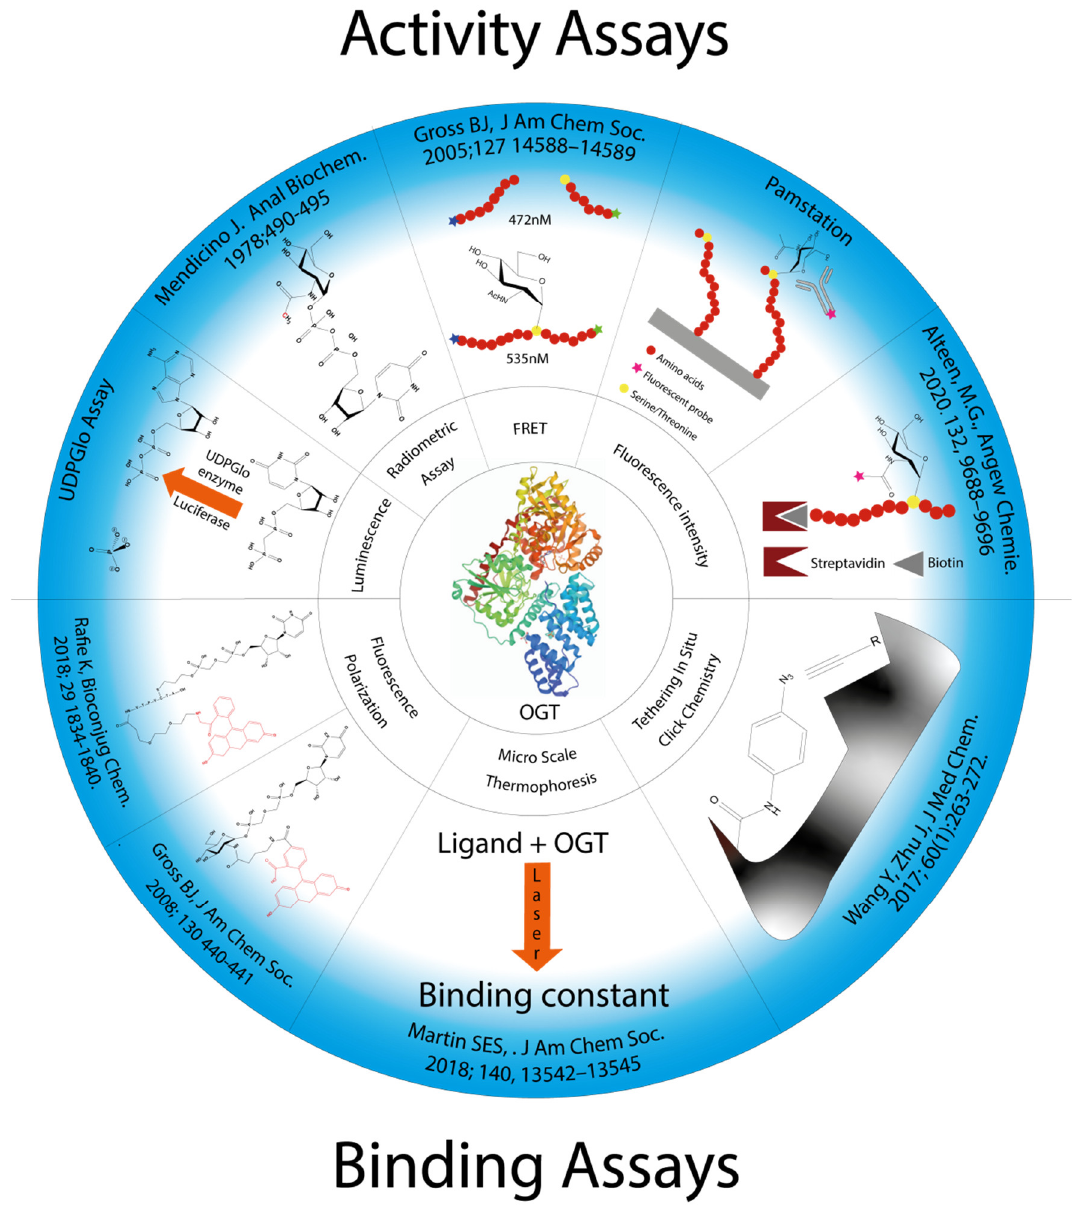
Figure 3. Presentation of all methods reported in the literature for screening OGT inhibitors and the techniques on which they are based.